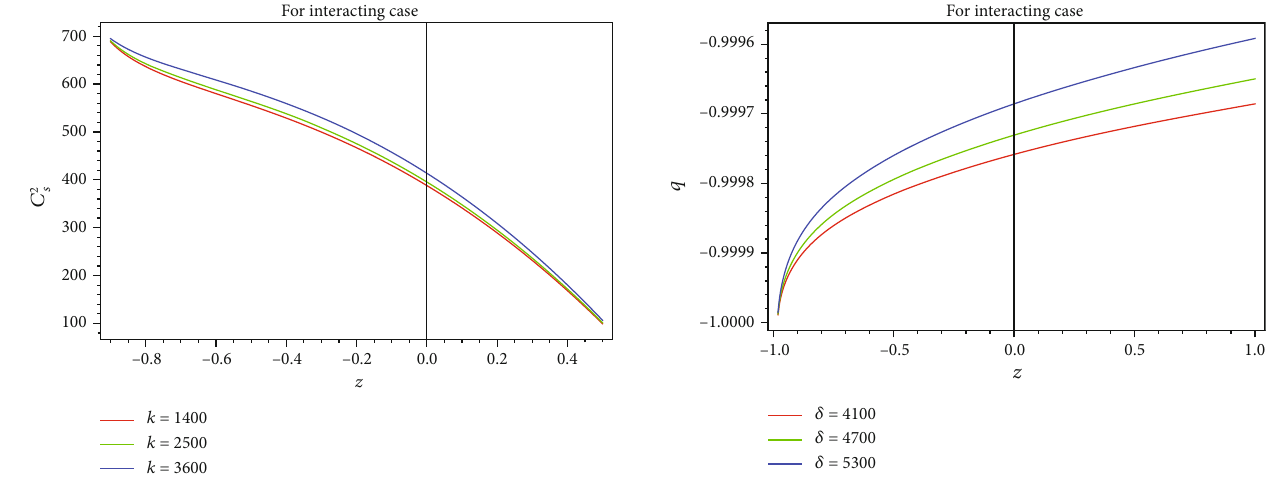
Figure 9: Variation of deceleration parameter q against redshift versus redshift s parameter z considering di ff erent values of δ when Ω